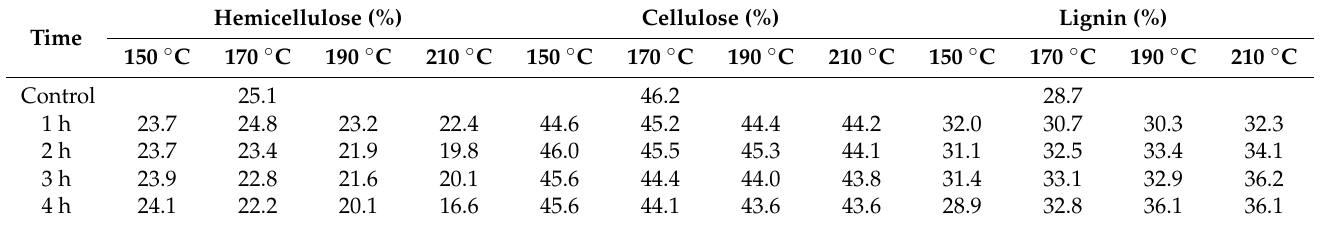
Table 1. Chemical composition proportions of treated bamboo samples after different temperature parameters .